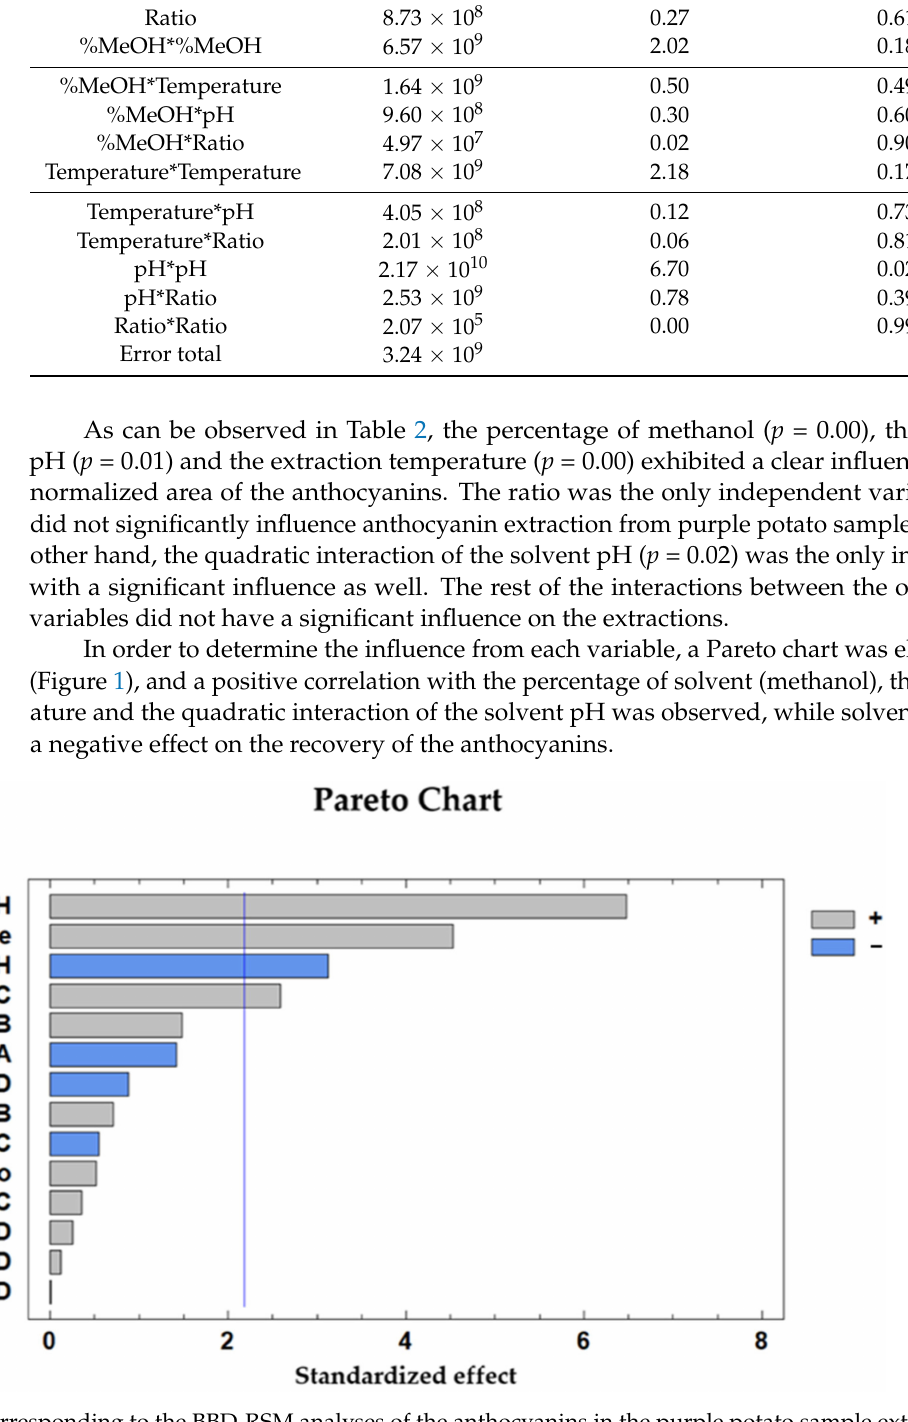
Figure 1. Pareto chart corresponding to the BBD-RSM analyses of the anthocyanins in the purple potato sample extracts. A: %MeOH in the solvent; B: extraction temperature; C: extraction solvent pH; D: sample-to-solvent